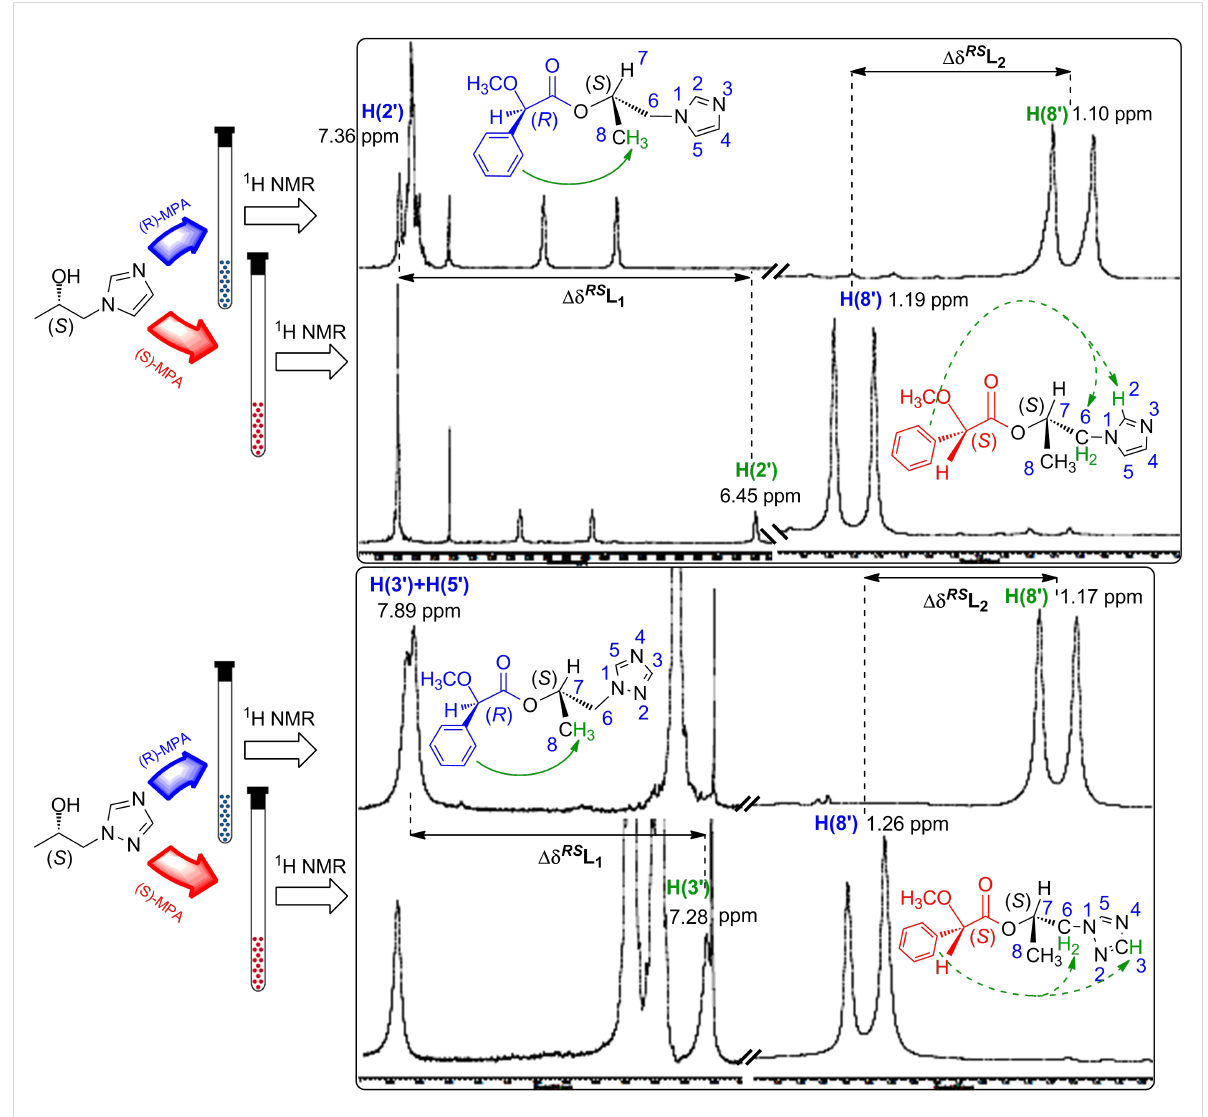
Figure 2: The 1 H NMR spectra of the derivatives of two unreacted chiral alcohols (+)- 5a (top) and (+)- 5b (bottom). Symbols marked in green repre- sent protons shielded by the phenyl ring of chiral auxiliary (MPA); blue labels stand for unaffected protons.